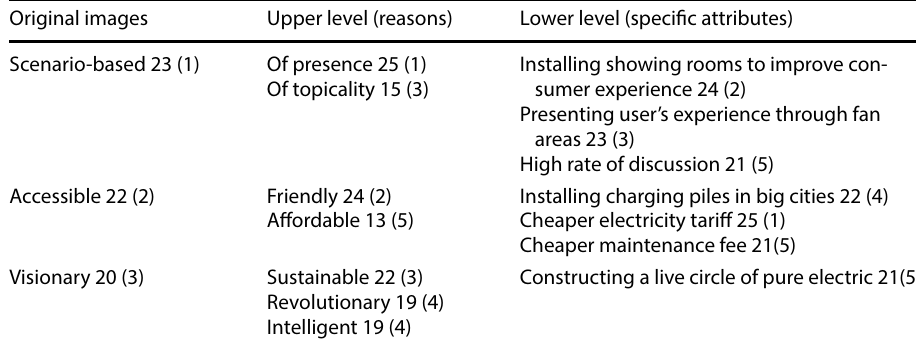
Table 3 Original impressions of the top five selected according to the number description in the EGM hierarchical chart and their reasons